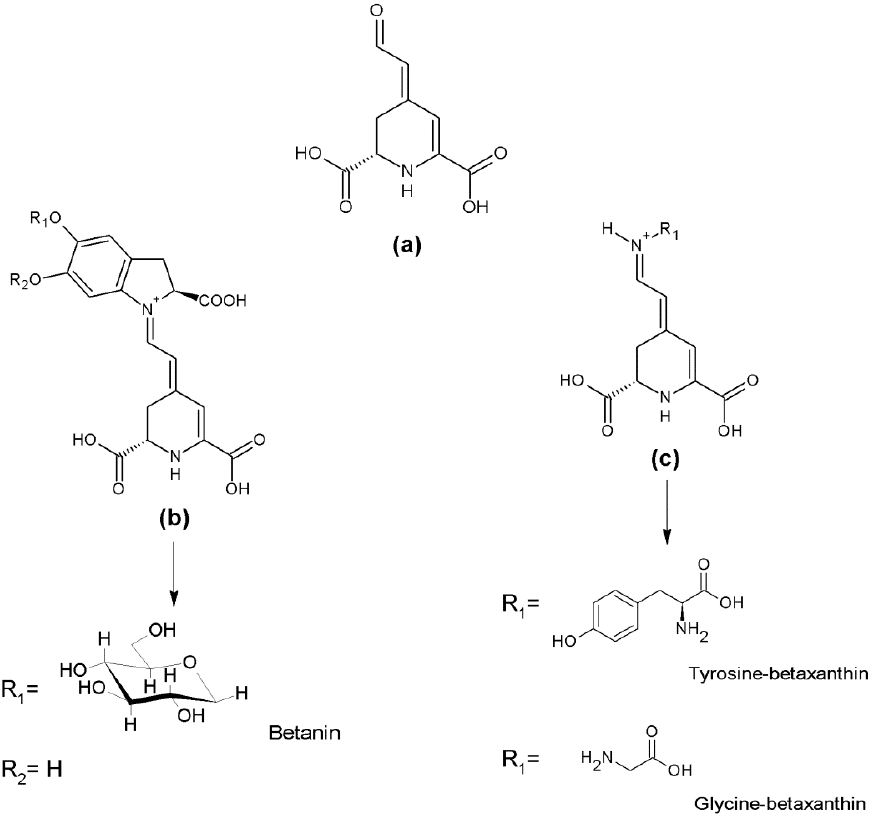
Figure 6. Betalamic acid ( a ), precursor of betalains. Betacyanins ( b ) and betaxanthins ( c ), as the main classes with some derivatives.